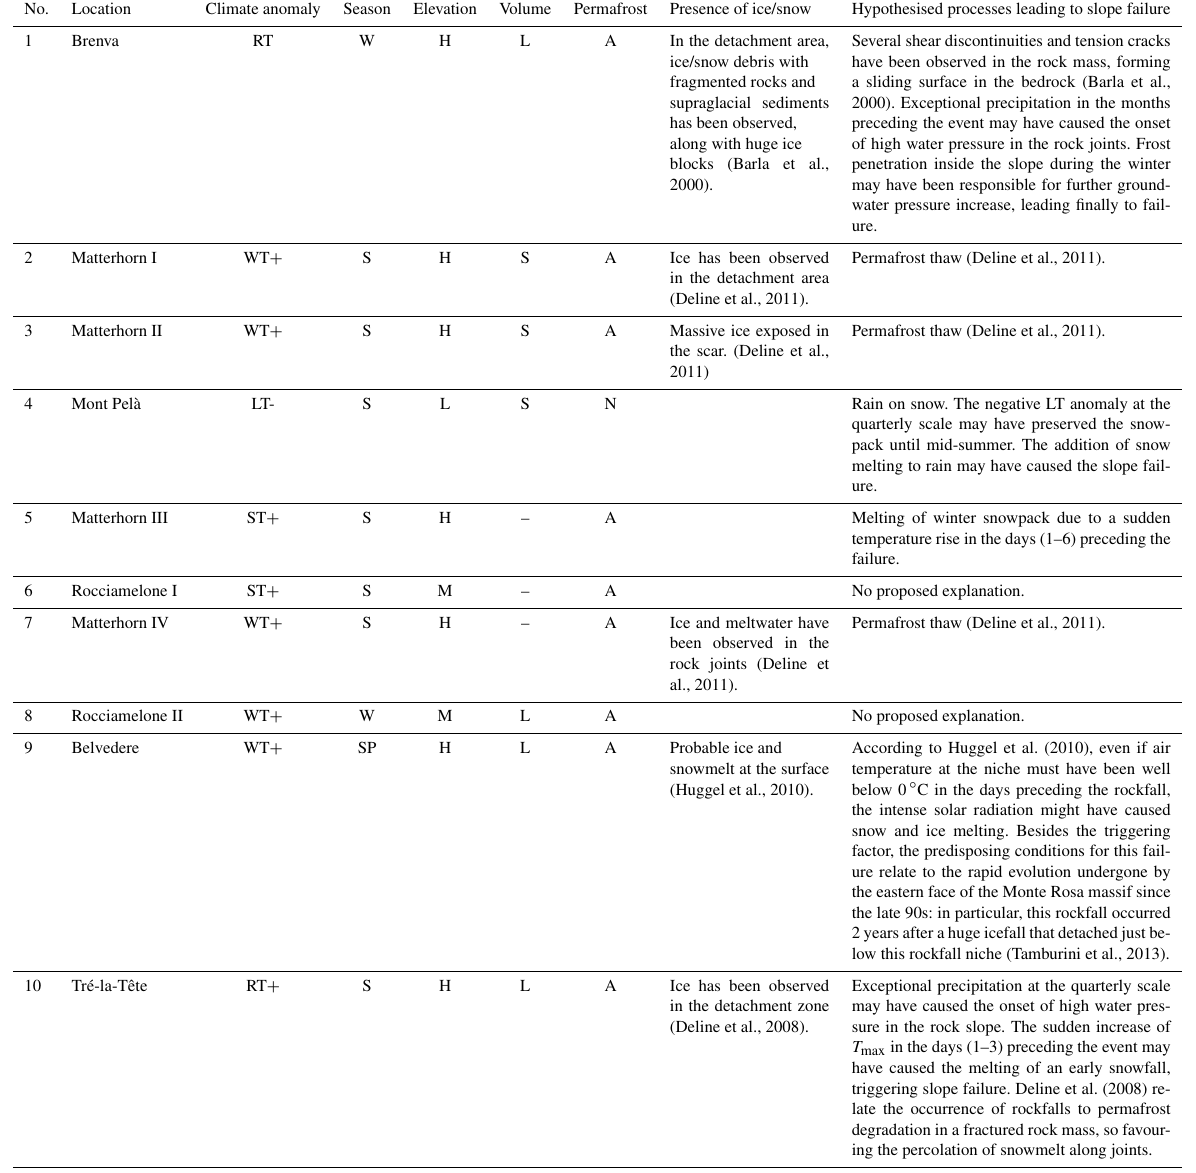
Table A1. Synthetic characterisation of case studies and possible processes leading to slope failure. Number (no.) and location of case studies are the same as in Table 1. Climate anomaly is the type of anomaly associated with rockfall occurrence: ST is short-term temperature anomaly; LT is long-term temperature anomaly; WT is widespread temperature anomaly; RT is precipitation anomaly – at the weekly range or longer – without or in association to temperature anomalies; NO indicates no anomaly. Positive temperature anomaly ( P(V ) ≥ 1 − α /2) is indicated as + while negative temperature anomaly ( P(V ) ≤ α /2) is indicated as − . The coexistence of both anomalies is indicated as ± . Season is the season of occurrence of rockfalls: W (winter), SP (spring), S (summer), A (autumn). Elevation is the range of elevation z of rockfall niche (ma.s.l.): L (1500 ≤ z <2400), M (2400 ≤ z <3300), H (3300 ≤ z ≤ 4200). Volume is the volume of detached rock (m 3 ) : small-volume (S, 10 2 ≤ volume<10 4 ) and large-volume (L, 10 4 ≤ volume<10 6 ) events. Permafrost is the expected permafrost occurrence in the detachment zone: A (permafrost in nearly all conditions), C (mostly in cold conditions), F (only in very favourable conditions), N (no